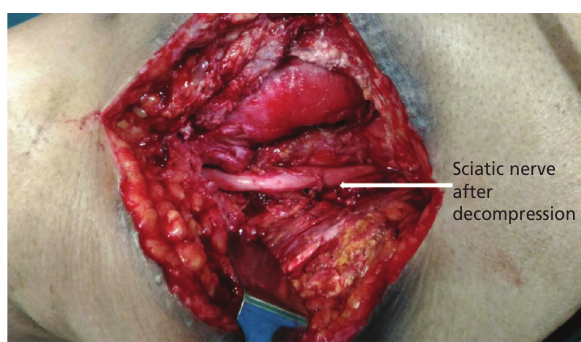
Plain AP radiograph of the pelvis in the immediate post- Fig. 1: operative period with bipolar prosthesis in situ.